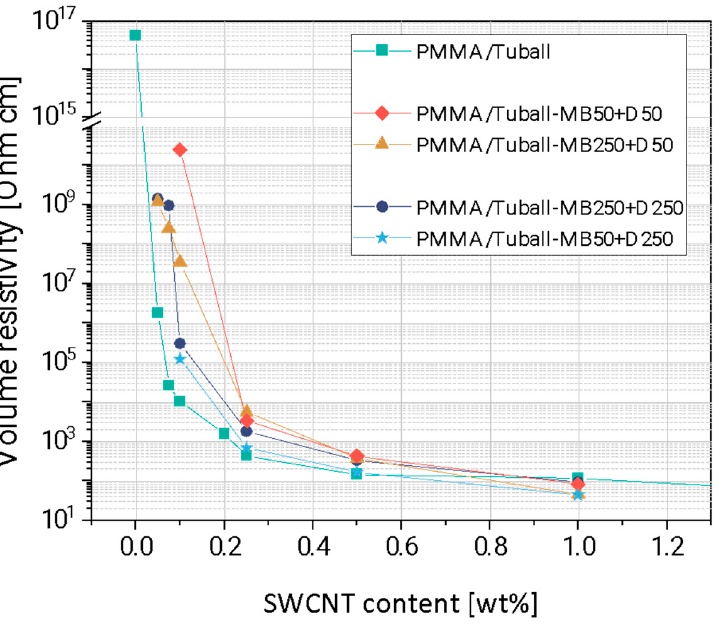
Figure 6. Electrical volume resistivity of PMMA/SWCNT composites prepared with the masterbatch diluting method at different rotation speeds compared with PMMA/SWCNT samples prepared at 250 rpm using direct incorporation.